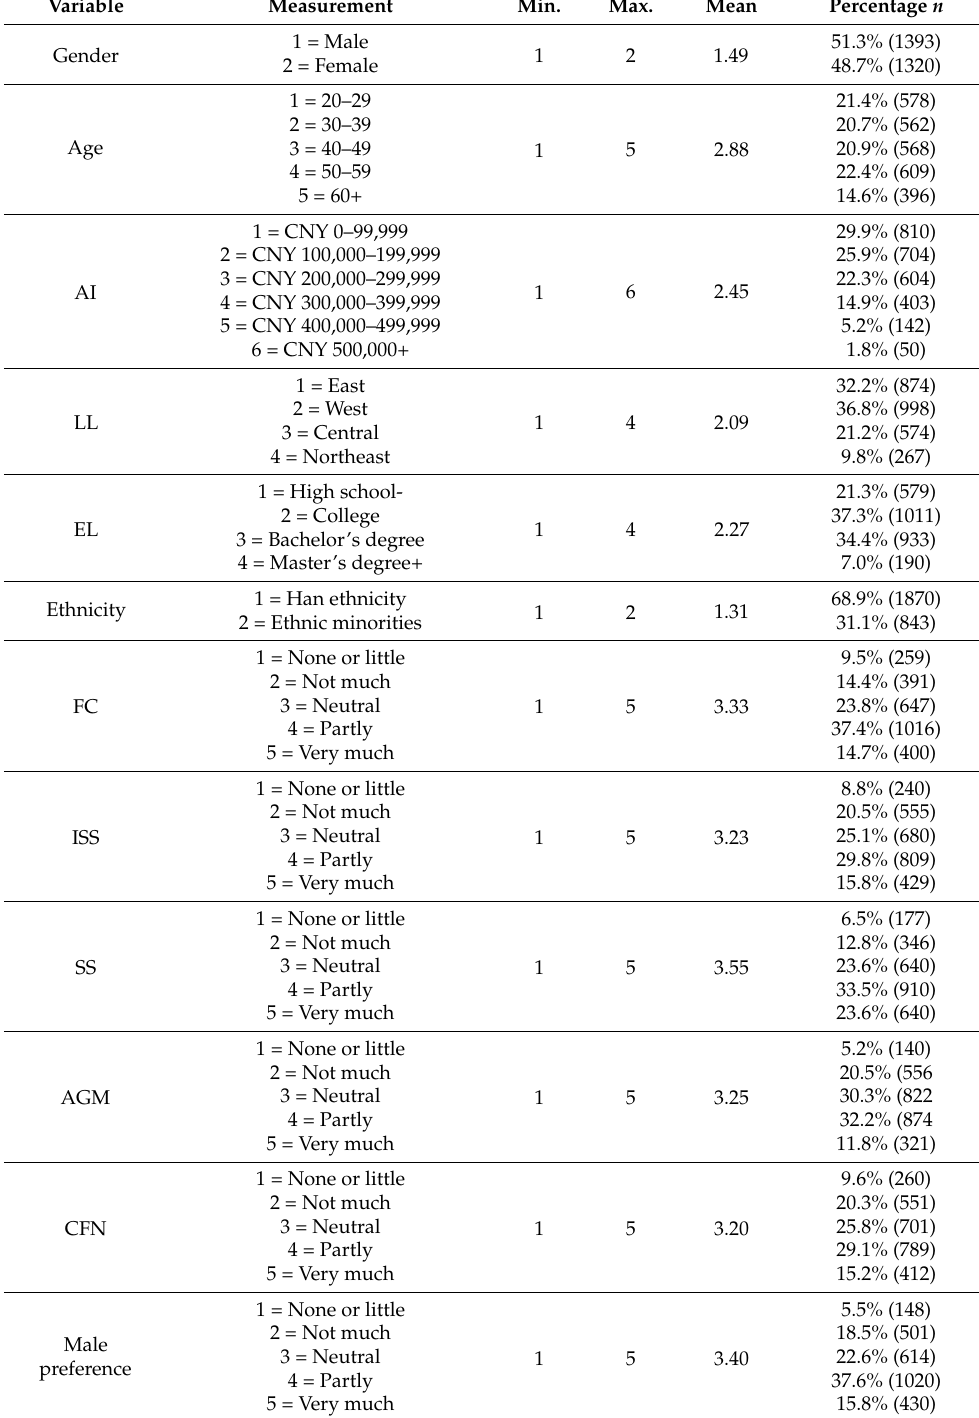
Table 2. Definitions and descriptions of the variables included in the survey ( n = 2713): gender, age, annual income (AI), living location (LL), educational level (EL), ethnicity, family contribution (FC), ideology of being supported by sons (ISS), social status (SS), ability to generate money (AGM), and carrying on the family name